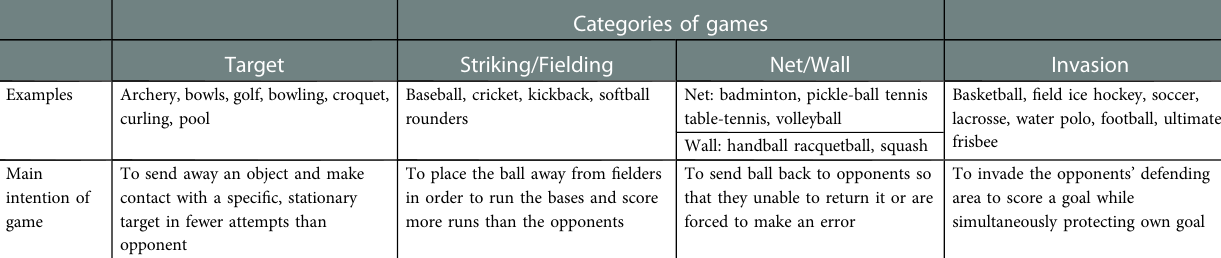
TABLE 1 The four categories of games chosen by the TGfU approach (this is a selection from the original table by Butler